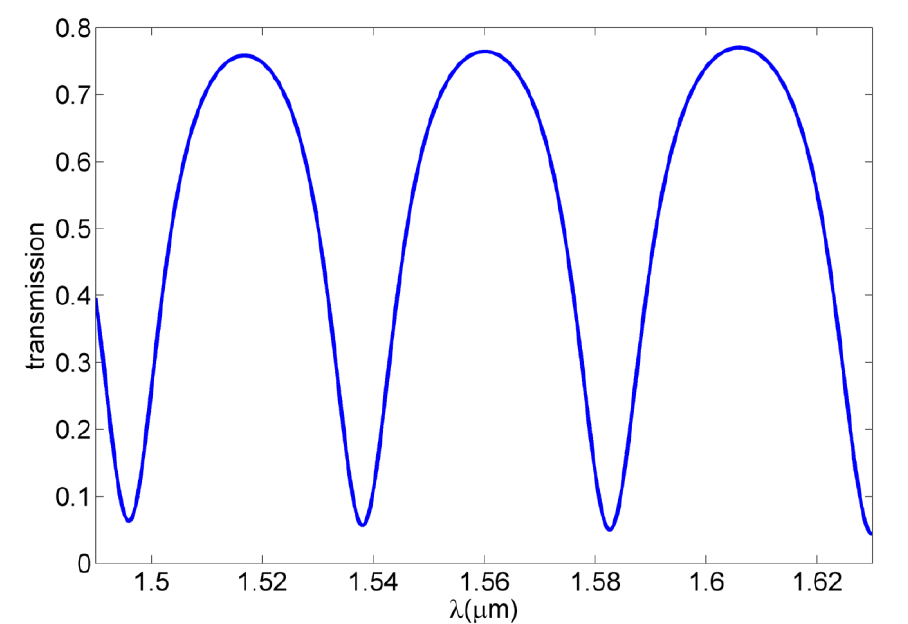
Figure 2. Transmission spectrum for an all-pass ring resonator based on